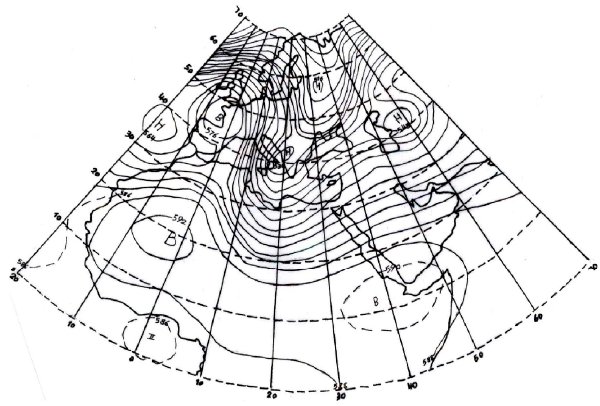
Fig. 7 The pattern of the geopotential heights at 500 hPa before the rainfall (Type II: 6 January 1978)